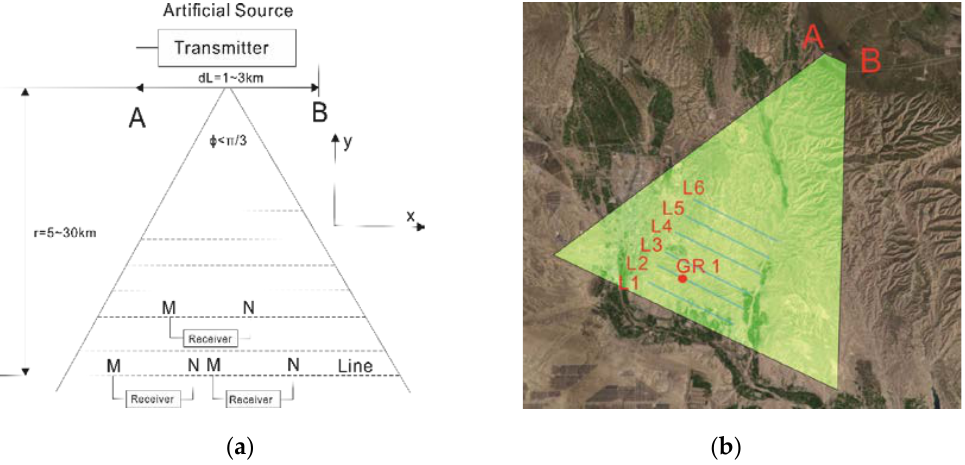
Figure 2. WFEM method survey design. The red dot represents the well GR1: ( a ) The schematic diagram and ( b ) The actual construction layout.